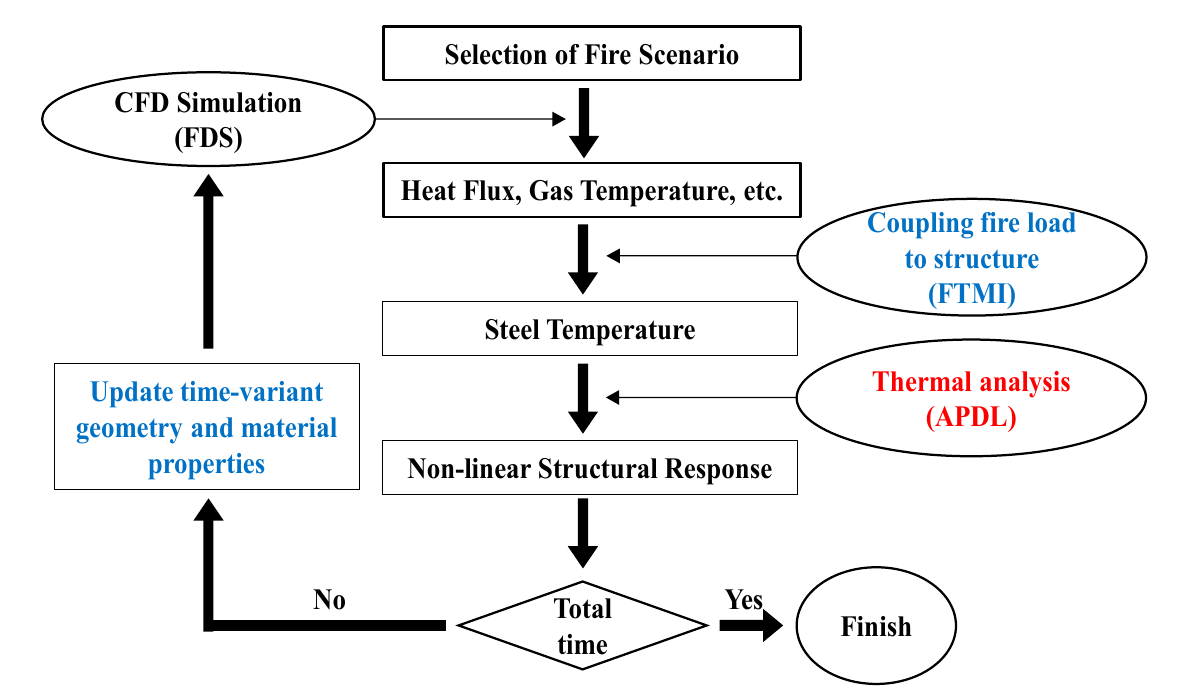
Figure 4. Analytical logic of the two-way fluid-structure interaction for determining the non-linear structural response to fire. FDS: Fire Dynamics Simulator; FTMI: Fire-Thermochemical Interface; APDL: ANSYS Parametric Design Language.